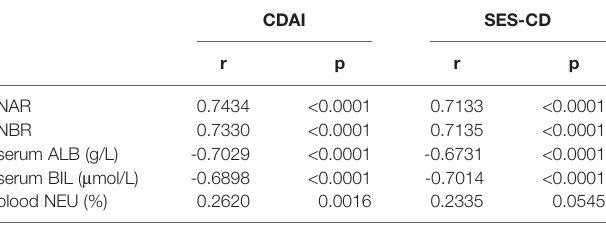
TABLE 2 | Associations of different parameters with CD activity.